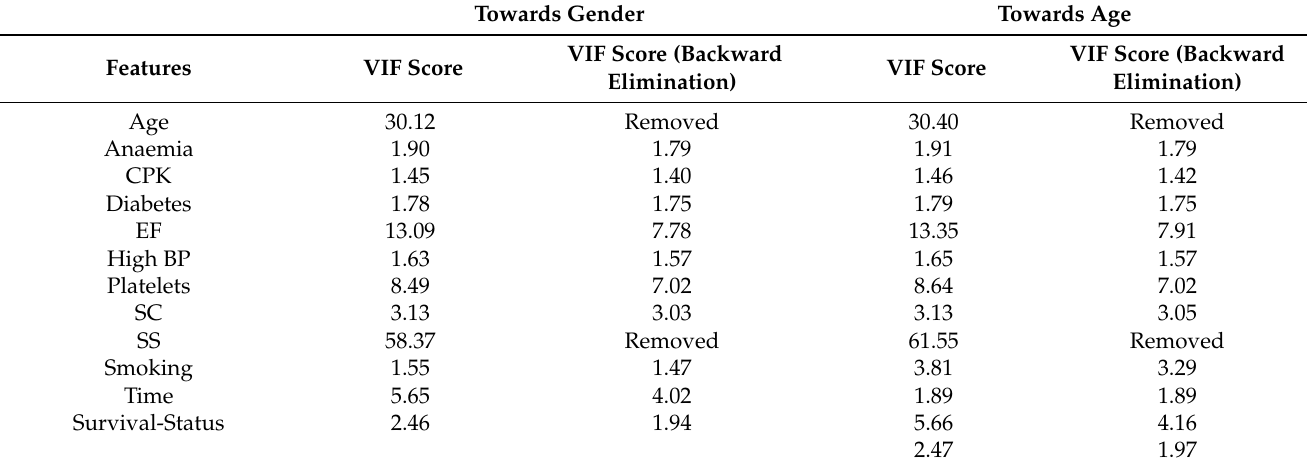
Table 3. Feature’s VIF of Gender and Age.